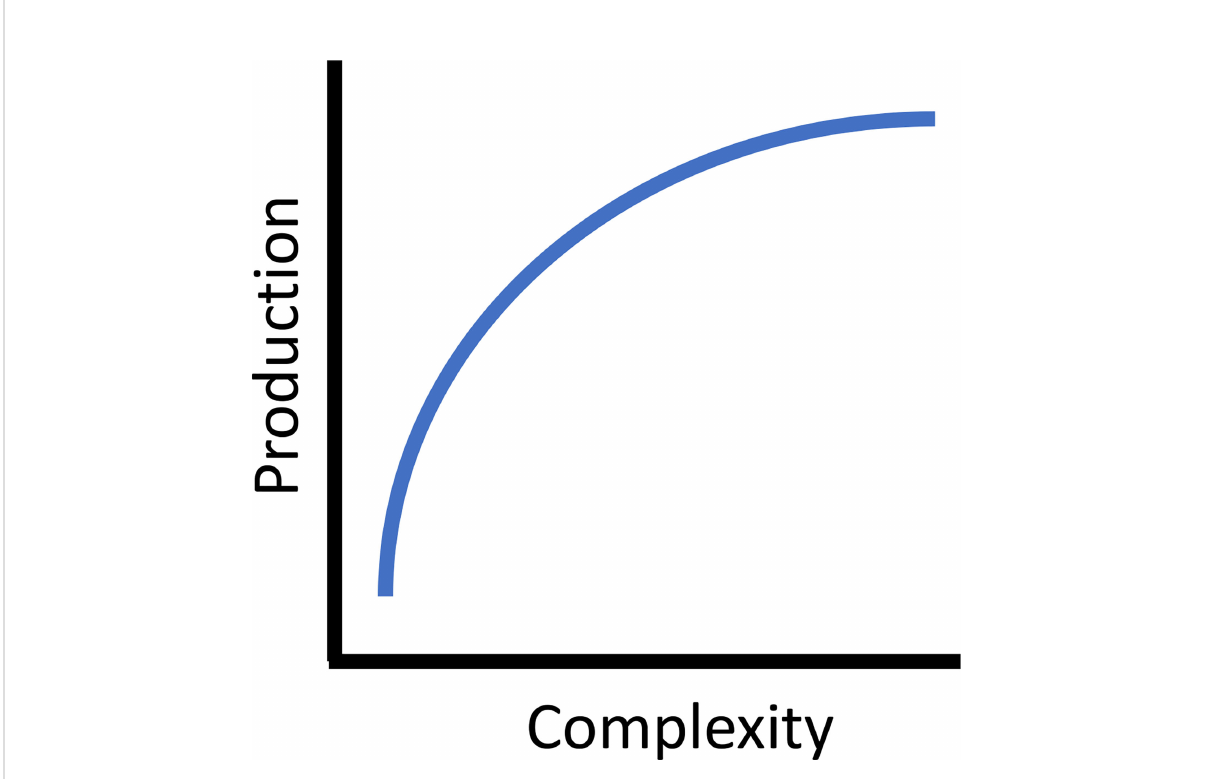
FIGURE 2 The asymptotic theoretical relationship between reef complexity and secondary ( fi sh)